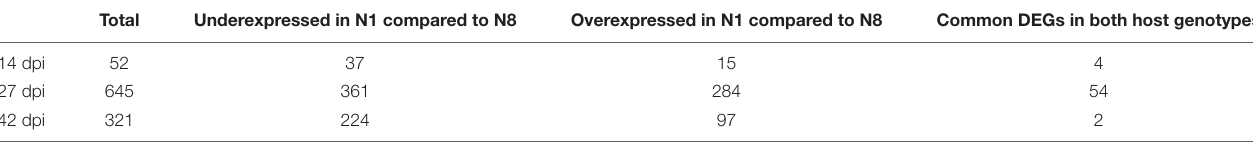
TABLE 2 | Number of Plasmodiophora brassicae DEGs depending on the nitrogen supply. Total Underexpressed in N1 compared to N8 Overexpressed in N1 compared to N8 Common DEGs in both host genotypes